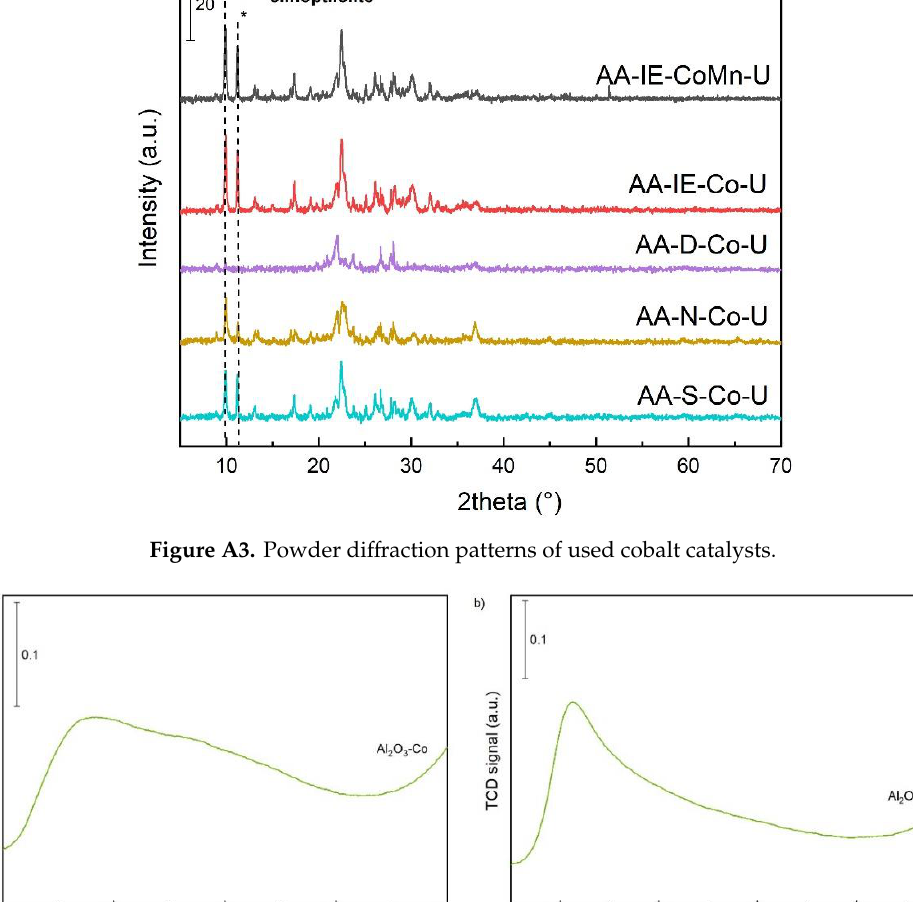
Figure A2. Powder di ff raction patterns of Al 2 O 3 support, fresh and used cobalt catalyst.